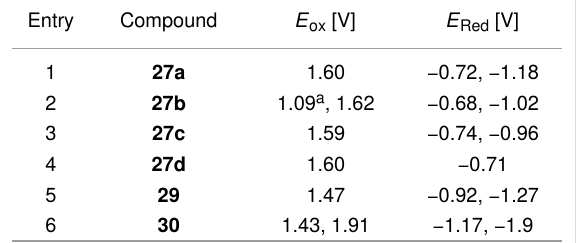
Table 3: Electrochemical data for rhenium complexes 27a – d , 29 and 30 . For full scan range ( − 2.0 V to 2.5 V), please refer to the Support- ing Information File 1 (Figures S5, S6, and